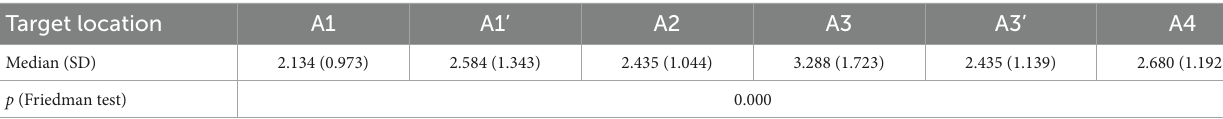
TABLE 8 Results of the searching time along the different